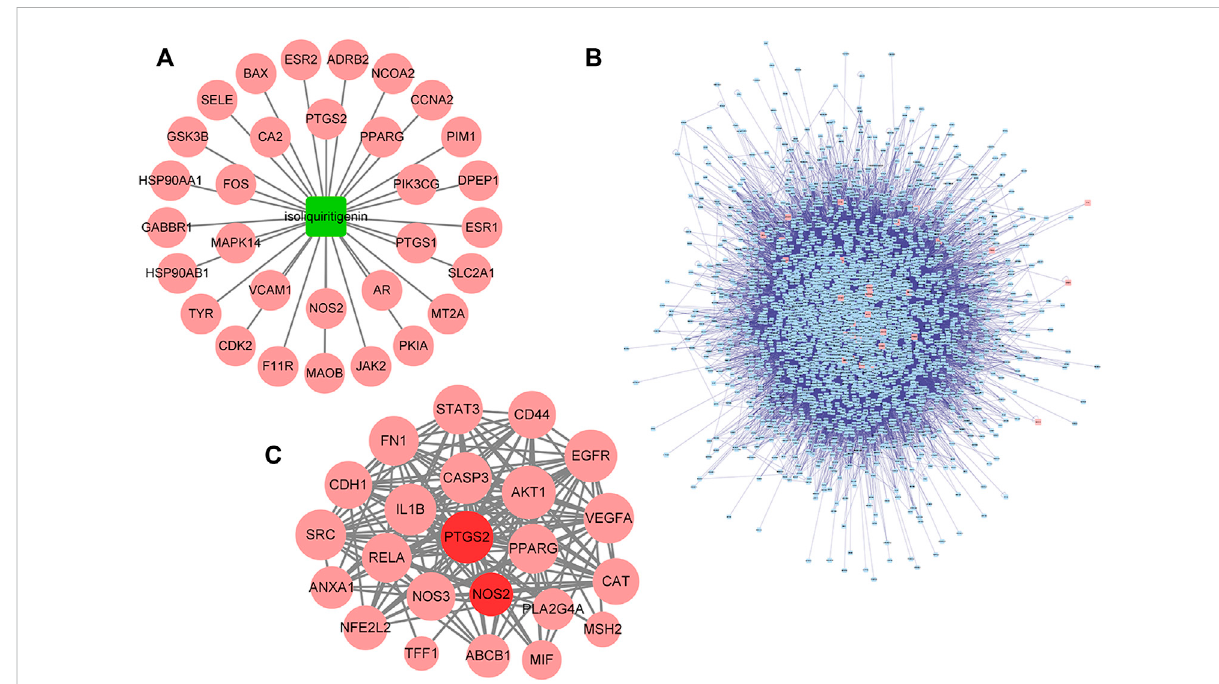
FIGURE 3 TargetsofISLagainst5-FUgastrointestinaltoxicitypredictedbynetworkanalysis. (A) TheISL-targetnetwork.ThenodeingreencolorisISL,and the nodes in red color are candidate targets of ISL. (B) Protein interaction network of ISL target (iT) and its related target (rT). The nodes in red color areiTs,andthenodesinbluecolorarerTs. (C) Proteininteractionnetworkofpotentialtargets(pT)ofISLfordetoxi fi cation.Thenodesinredcolorare pTs for ISL against the gastrointestinal toxicity of 5-FU, the nodes in dark red color are the critical targets for the detoxi fi cation of